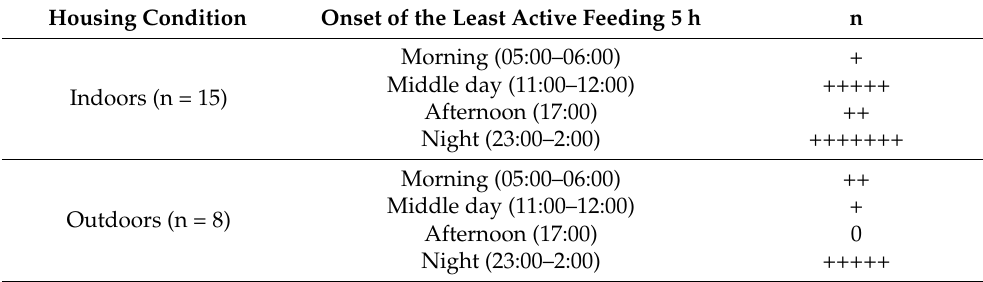
Table 2. Time of onset of the Least active feeding 5 h of the cats according to their housing condition. (+) represents one cat.